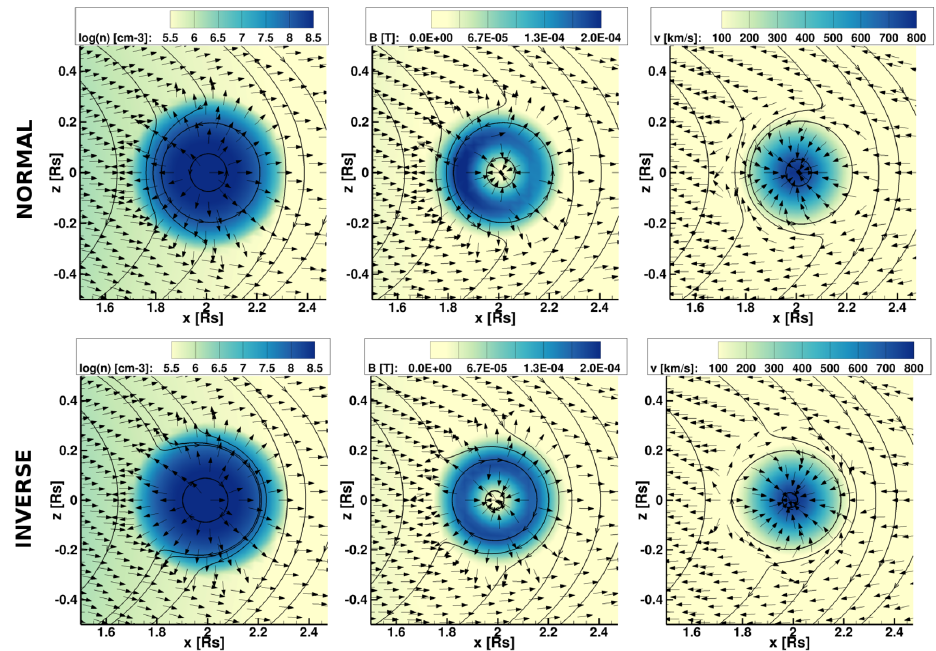
Figure 1. Forces at t = 0 h for a normal CME (upper row) and an inverse CME (lower row), both ejected with an initial velocity of 800 km/s in a medium density background wind. The black lines depict selected magnetic field lines in all figures. The magnetic field lines that are not part of the CME itself represent the coronal helmet streamer, which stretches around the CME for a normal polarity and behind it for an inverse polarity. The colour contours in the figures in the left column shows the logarithm of the number density, and the vector arrows depict the plasma pressure gradient force direction. The middle and right columns do the same, but for the magnetic field strength and the speed for the colour contours, respectively, and the magnetic pressure gradient force and the magnetic tension for the vectors,